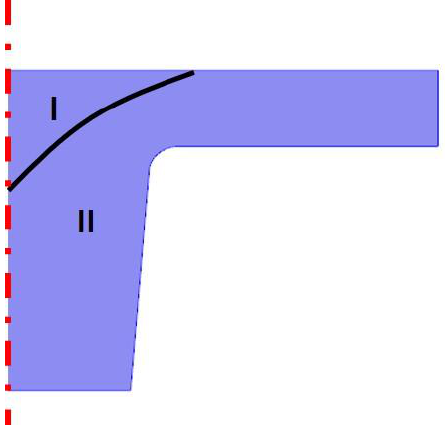
Figure 8. The schematic of the partially swelled nanostructure.